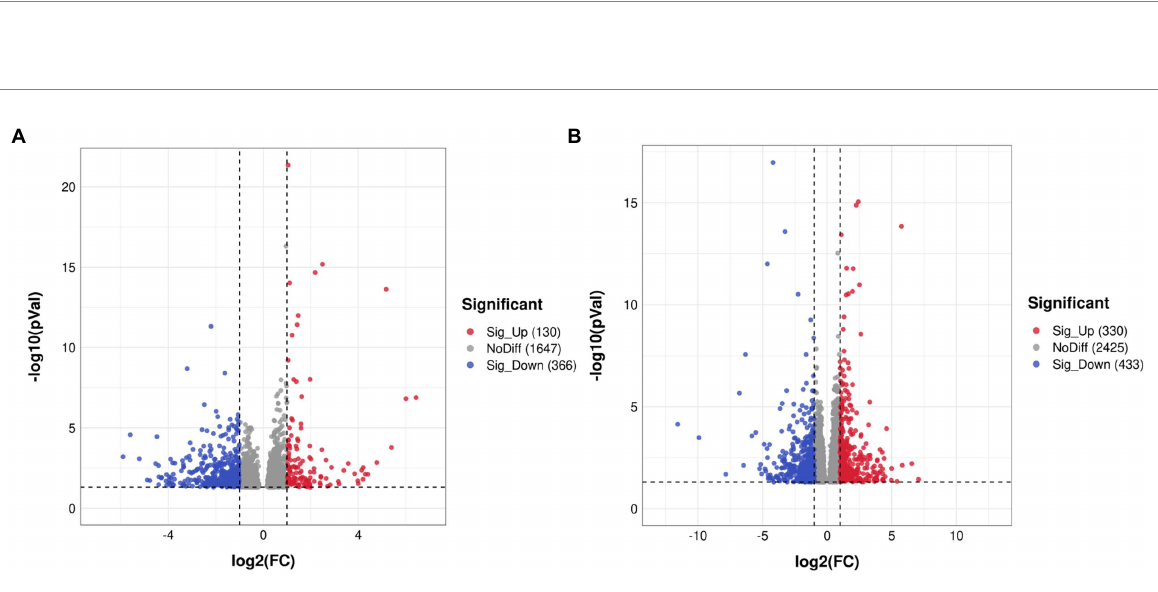
FIGURE 5 Volcano plots showing distribution trends for differentially expressed genes ( n = 4 per group). (A) SMPS and VPA groups; (B) SMPS and C groups. Red and blue dots indicate up- and downregulated DEGs, respectively; gray dots indicate that the genes were not differentially